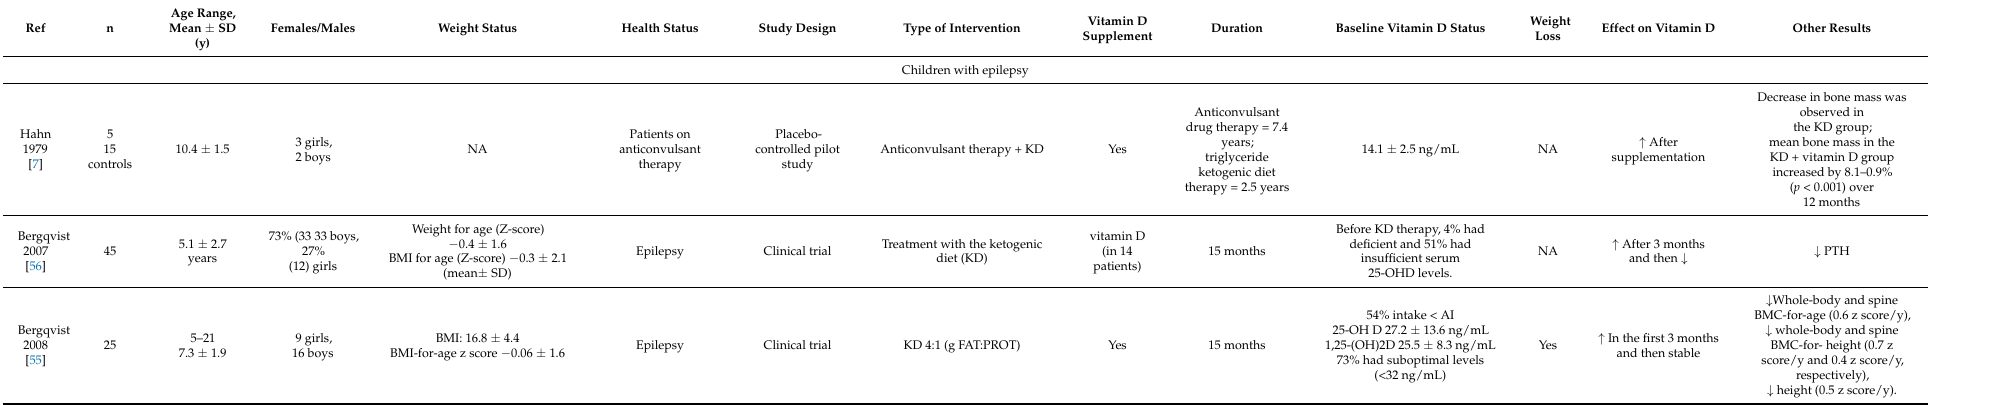
Table 2. Intervention studies with KD in patients with epilepsy in which vitamin D status was assessed pre- and